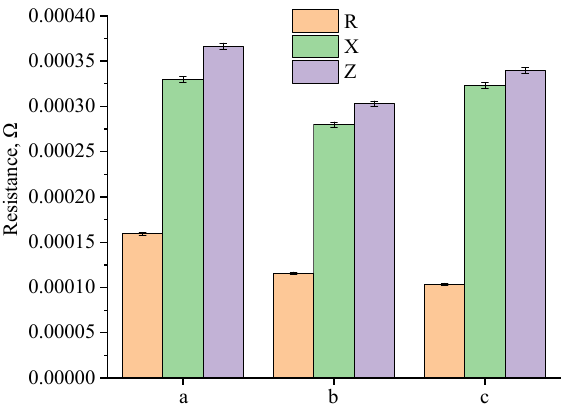
Figure 22. Resistance values of ABE wire samples: (a) ABE wires treated by sequential immersion in tetraethoxysilane and ammonia (five cycles); (b) ABE wires treated by immersion in SiO 2 nanoparticles sol (five cycles); (c) uncoated wires (control sample).